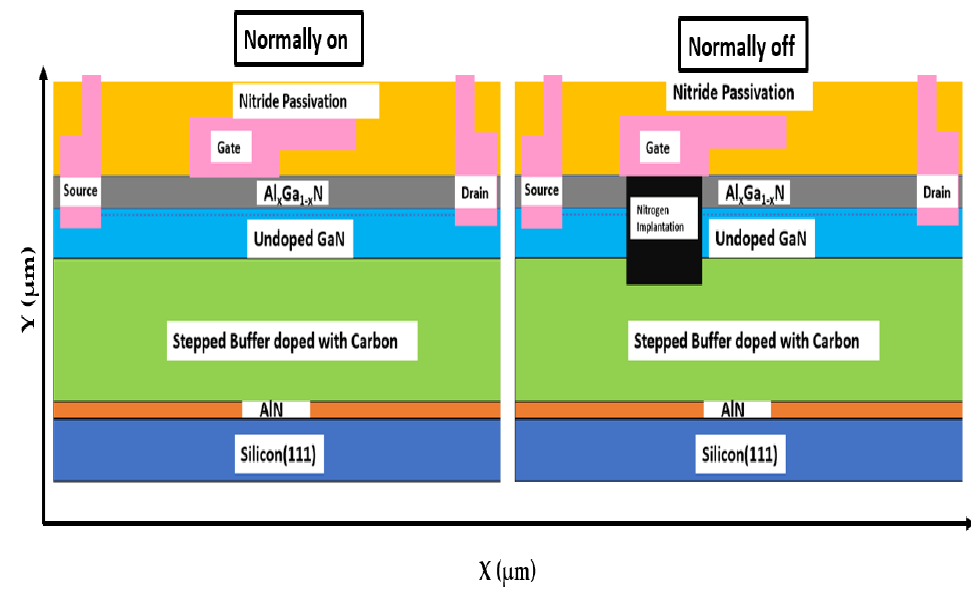
Figure 1. Schematic device structure of normally on and normally off AlGaN/GaN HEMT.